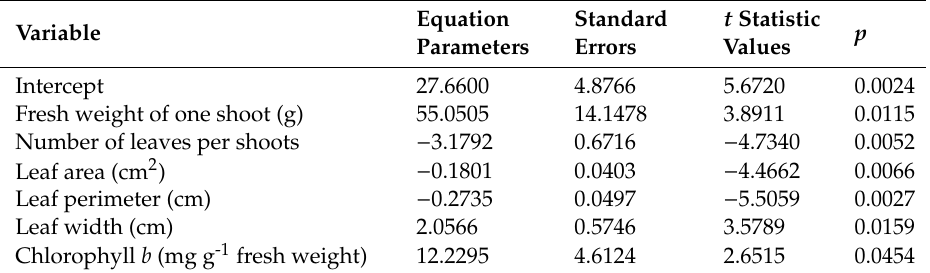
Table 3. Estimated equation parameters and statistics for stepwise (backward elimination) multiple regression performed for the multiplied plantlets’ number of shoots.